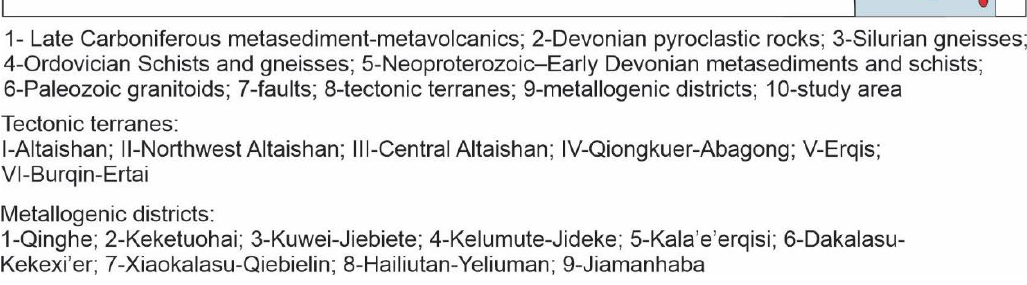
Figure 1. Geological map of the Chinese Altay orogen (after [2,3]). Abbreviations: CAOB = the Central Asian Orogenic Belt.